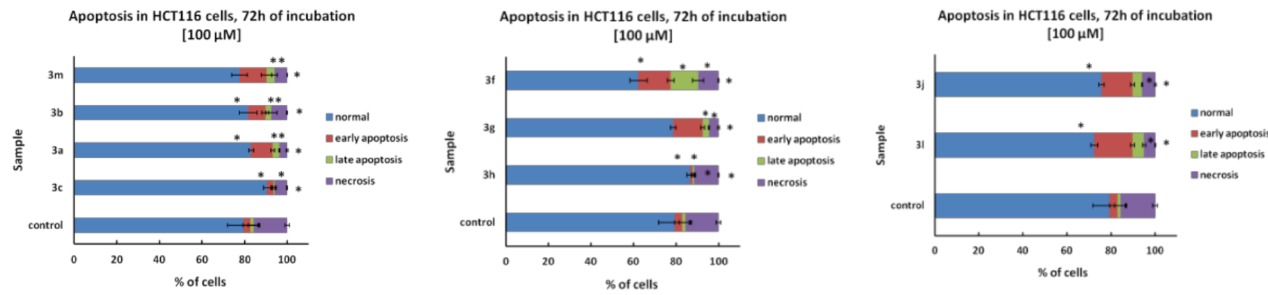
Figure 9. Apoptosis in HCT116 after a 72h incubation with compounds with a concentration of 100 µ M. The results were presented as mean value ± SD. The statistical analysis was based on a t-test, and a p -value less than 0.05 was considered statistically significant in comparison to the untreated controls (indicated with a star).